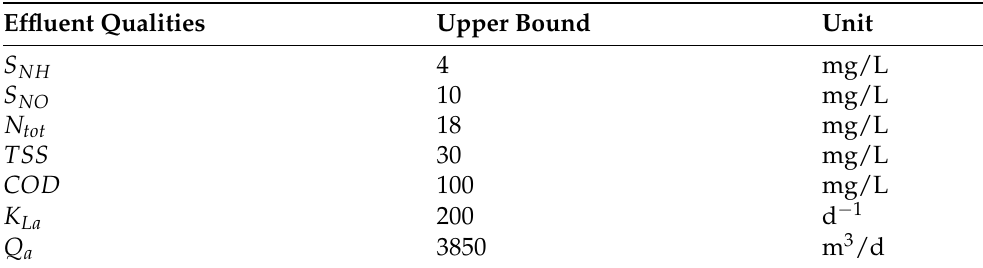
Table 4. Bounds of the effluent